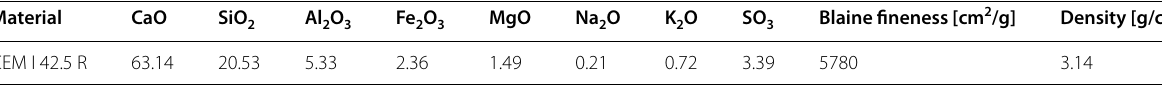
Table 1 Chemical composition and physical properties of cement [wt%] Material